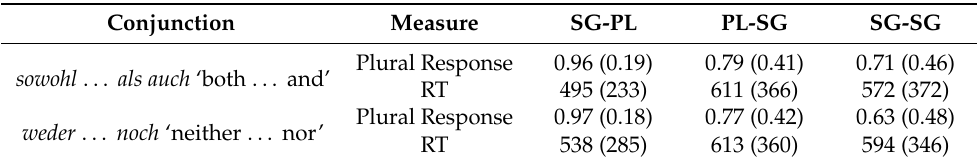
Table 5. Proportions of plural responses and response times (RT) in milliseconds (SDs in parentheses) per condition for both conjunctions, Experiment 2 (SG = singular, PL =